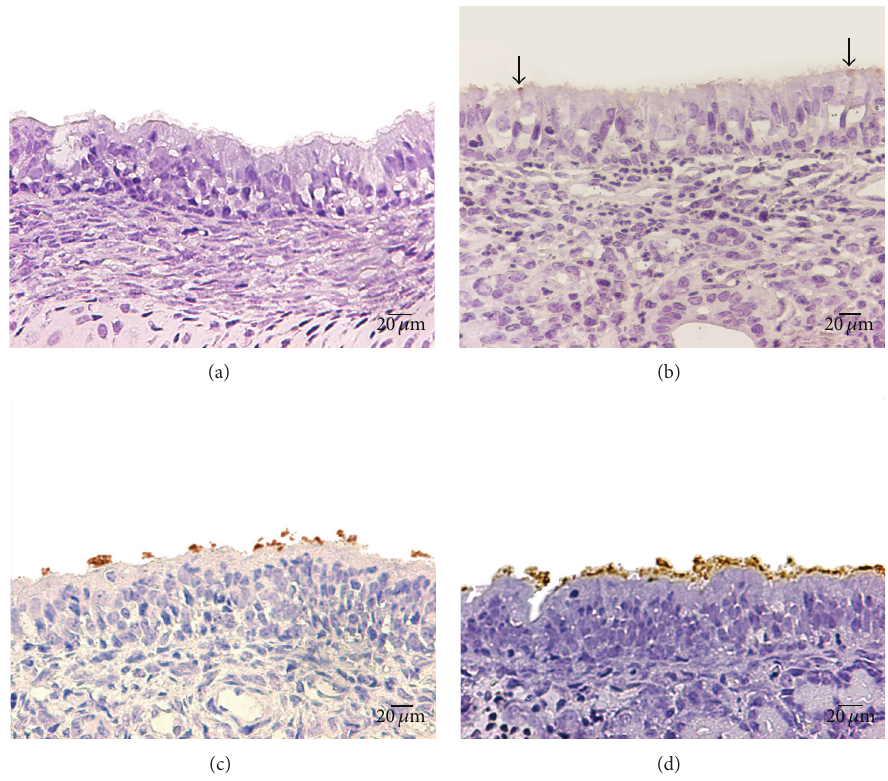
Figure 1: IIP technique for determining the percentage of the epithelial surface covered by adherent P. multocida . (a) Normal fetal rabbit respiratory nasal epithelium of IIP, negative control; light microscopy (LM), scale bar = 20 𝜇 m. (b) Respiratory epithelium of the nasal septa of rabbit fetus preincubated with PNA plus P. multocida (sparse focal immunostaining (arrows); > 0–30% of the epithelial surface); LM, scale bar = 20 𝜇 m. (c) Tissue preincubated with VVA and P. multocida showing multifocal immunostaining ( > 30–60% of the surface covered with bacteria); LM, scale bar = 20 𝜇 m. (d) Tissue incubated with P. multocida without lectins (positive control) showing generalized immunostaining ( > 60% of the epithelial surface covered by bacteria); LM, scale bar = 20 𝜇 m.